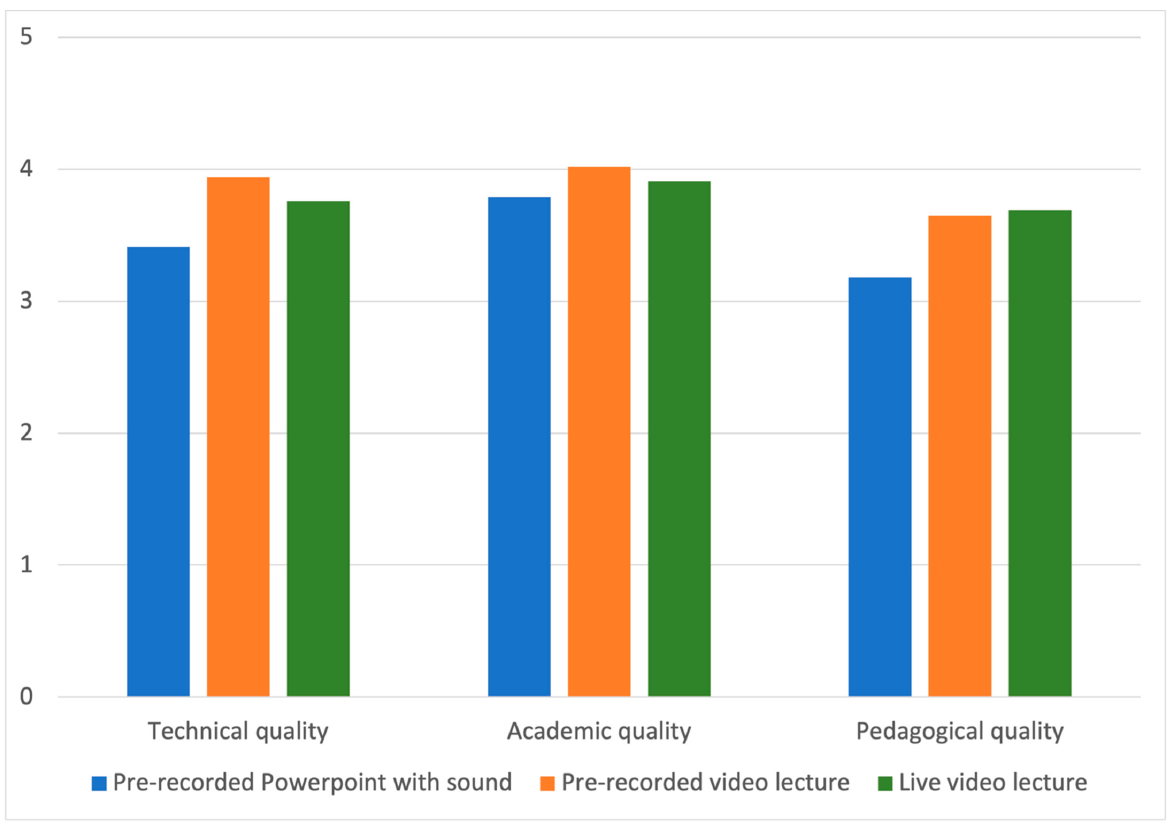
Figure 1. Student experience expressed on a Likert scale regarding technical, academic, and peda- gogical quality on pre-recorded PowerPoint with sound, pre-recorded video lectures and live video lectures.